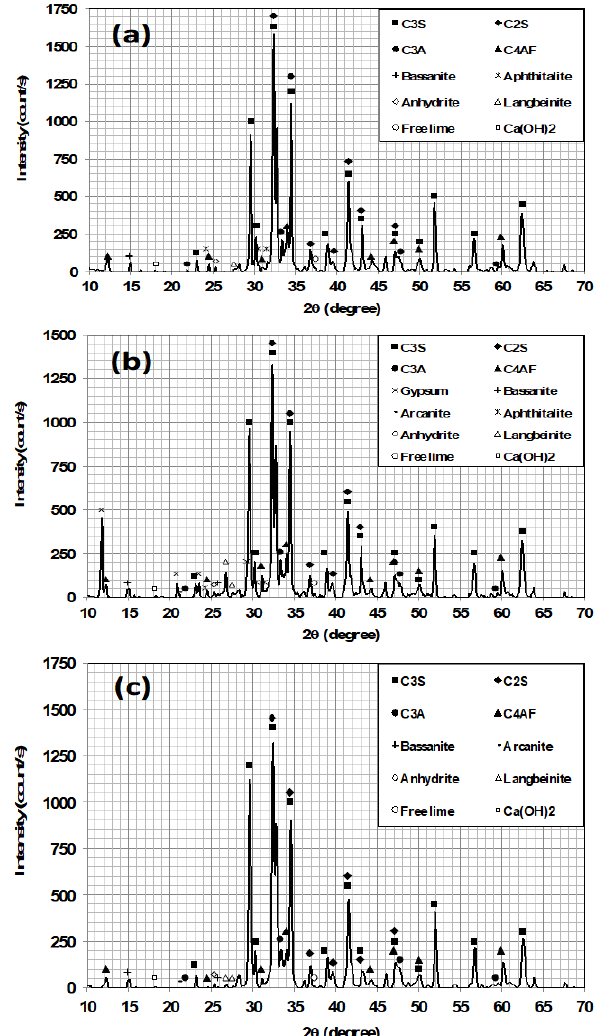
Figure 1. Diffractograms (a) Pure Clinker (b) Portland cement CPV-V (c) Portland cement CPV-I. (C 3 S) - 3CaOSiO 2 , (C 2 S) - 2CaOSiO 2 , (C 3 A) - 3CaOAl 2 O 3 , (C 4 AF) 4CaOAl 2 O 3 Fe 2 O 3 , Gypsum - CaSO 4 2H 2 O, Bassanite - CaSO 4 1/2H 2 O, Arcanite - K 2 SO 4